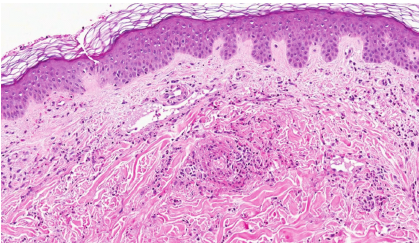
Figure 2: Leukocytoclastic vasculitis: fibrinoid necrosis of dermal vessels (hematoxylin-eosin, original magnification × 100) (photo courtesy of Dr. Rajendra